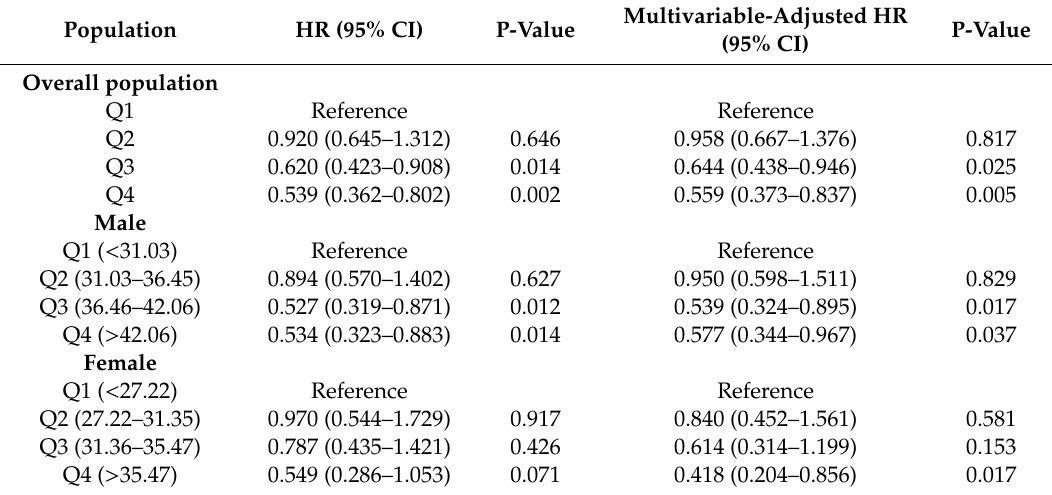
Table 3. Hazard ratios for 90-day mortality by muscle area index quartile in study